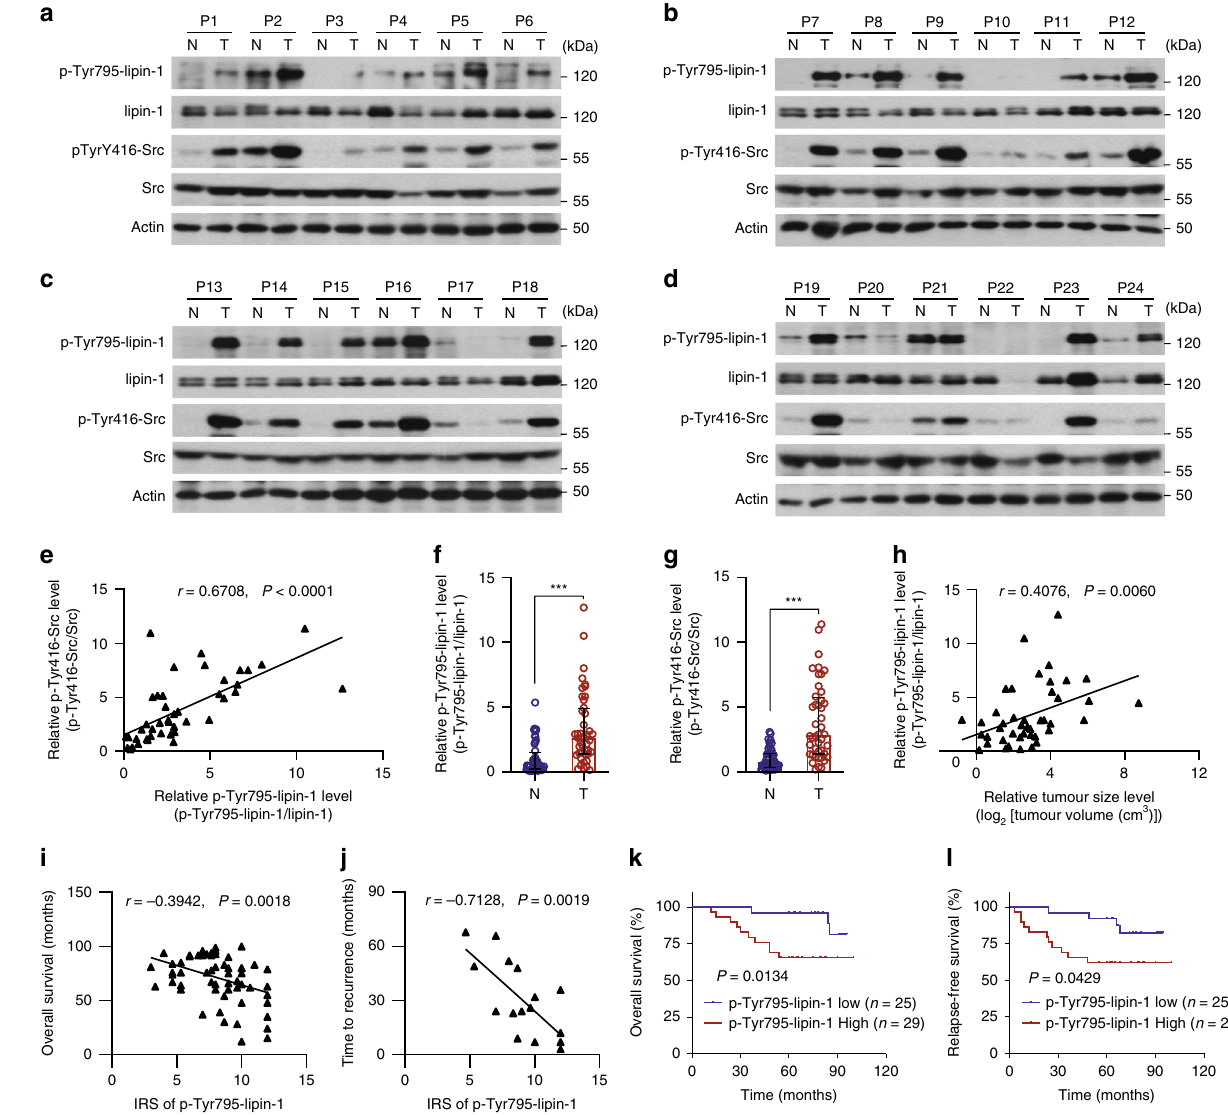
Fig. 5 Activation of Src – lipin-1 axis in human breast cancers and its correlation with clinical and pathological parameters. a – d Immunoblot analysis of p-